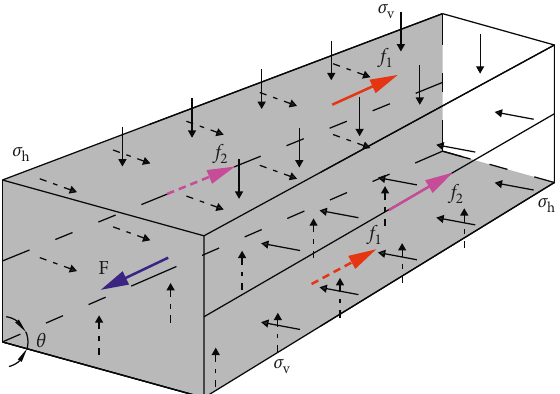
Figure 3: Schematic of the force analysis for cut